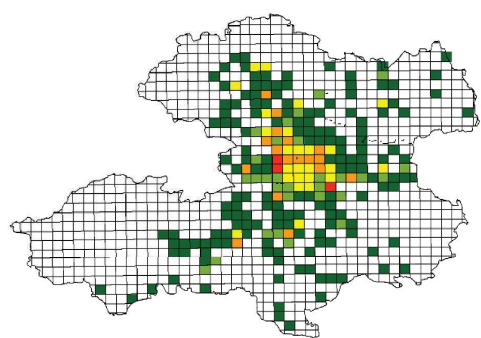
Figure 16: Distribution of universities.